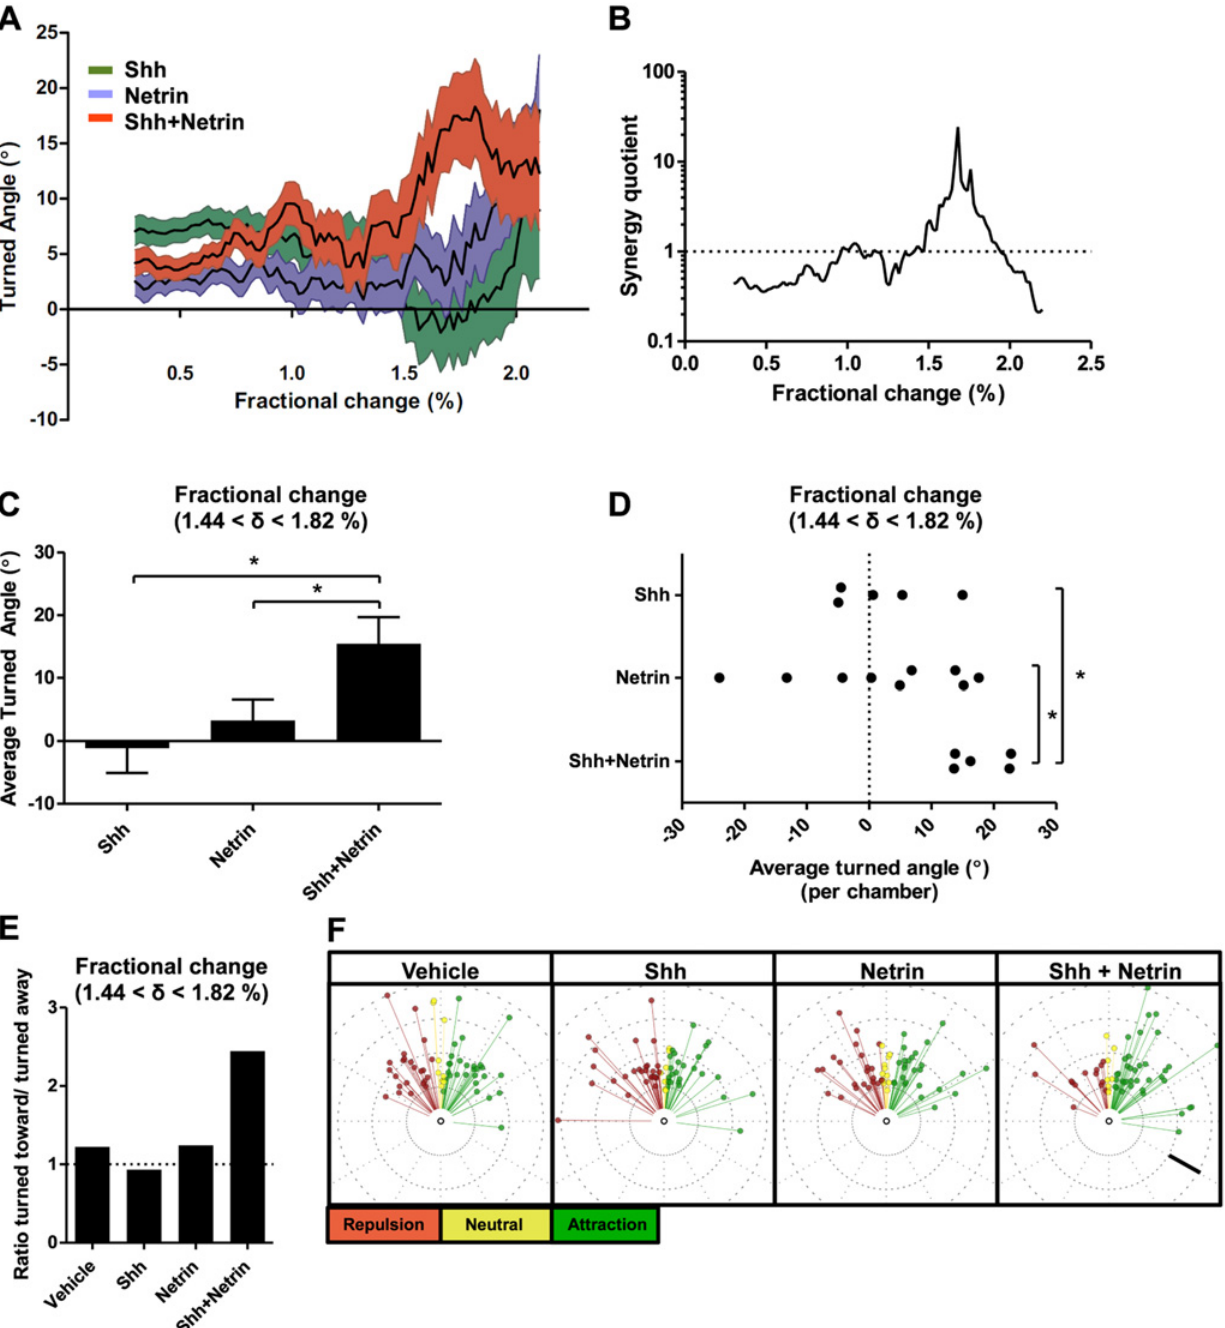
Fig 5. A combined gradient of Shh and Netrin-1 enhances axon guidance when the fractional change is sub-optimal for guidance towards a single cue. (A) Average turned angle as a function of fractional change when axons are exposed to gradients for 45 h. Axons exposed to gradients of Shh (green) or Netrin-1 (blue) have a maximum response when the fractional change is at its highest, δ = 2.2%. A combined gradient of Shh and Netrin-1 (red) induce turning to a similar magnitude as either cue individually at δ = 2.2%, but induce turning that is higher than for either cue individually when the fractional change is below its maximum (1.4 < δ < 1.8%). Mean and error of the average turned angle within a window of 0.5% are shown (Shh: 31 < n (cid:1) 1,004; Netrin: 38 < n (cid:1) 1,107; Shh+Netrin: 40 < n (cid:1) 1,164). (B) We defined the synergy quotient as the ratio of the turning towards the combined gradient to the sum of the turning to either cue individually (calculated using the means from A). For the majority of the combined gradient, the combined influence is sub-additive. However, the combined cues act synergistically when the fractional change is (1.44 < δ < 1.82%), just below its maximum value. (C) At this fractional change (1.44 < δ < 1.82%), axons responded much more robustly than for either cue individually, resulting in a higher average turned angle. (D) The synergy observed when 1.44 < δ < 1.82% is consistent between independent experiments (Shh: n = 5; Netrin: n = 9; Shh+Netrin: n = 5; p = 0.043 one-way ANOVA with